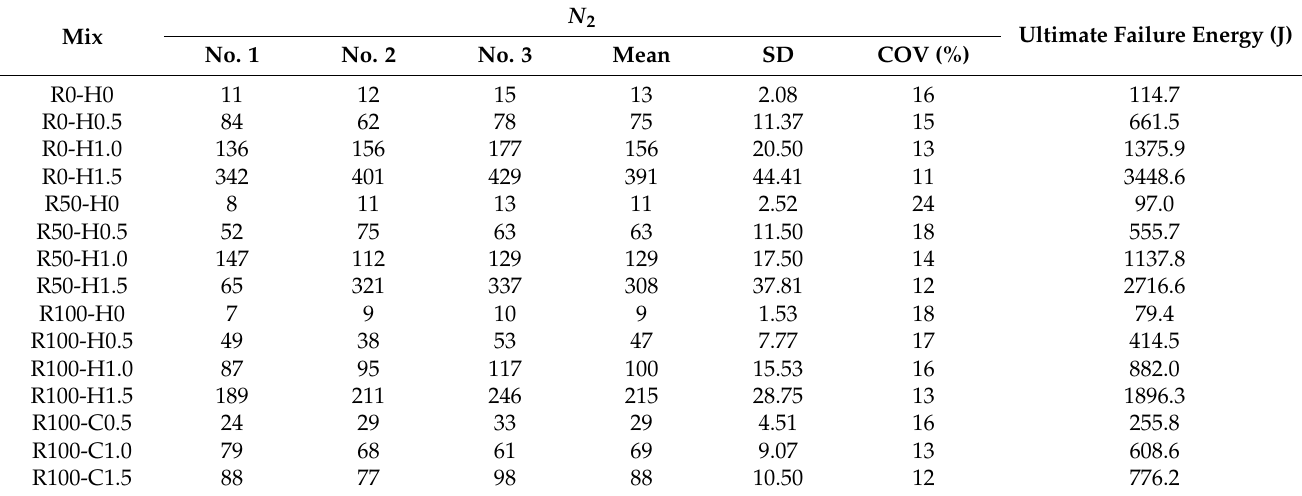
Table 7. The impact resistance of final crack for steel fiber-reinforced RAC.